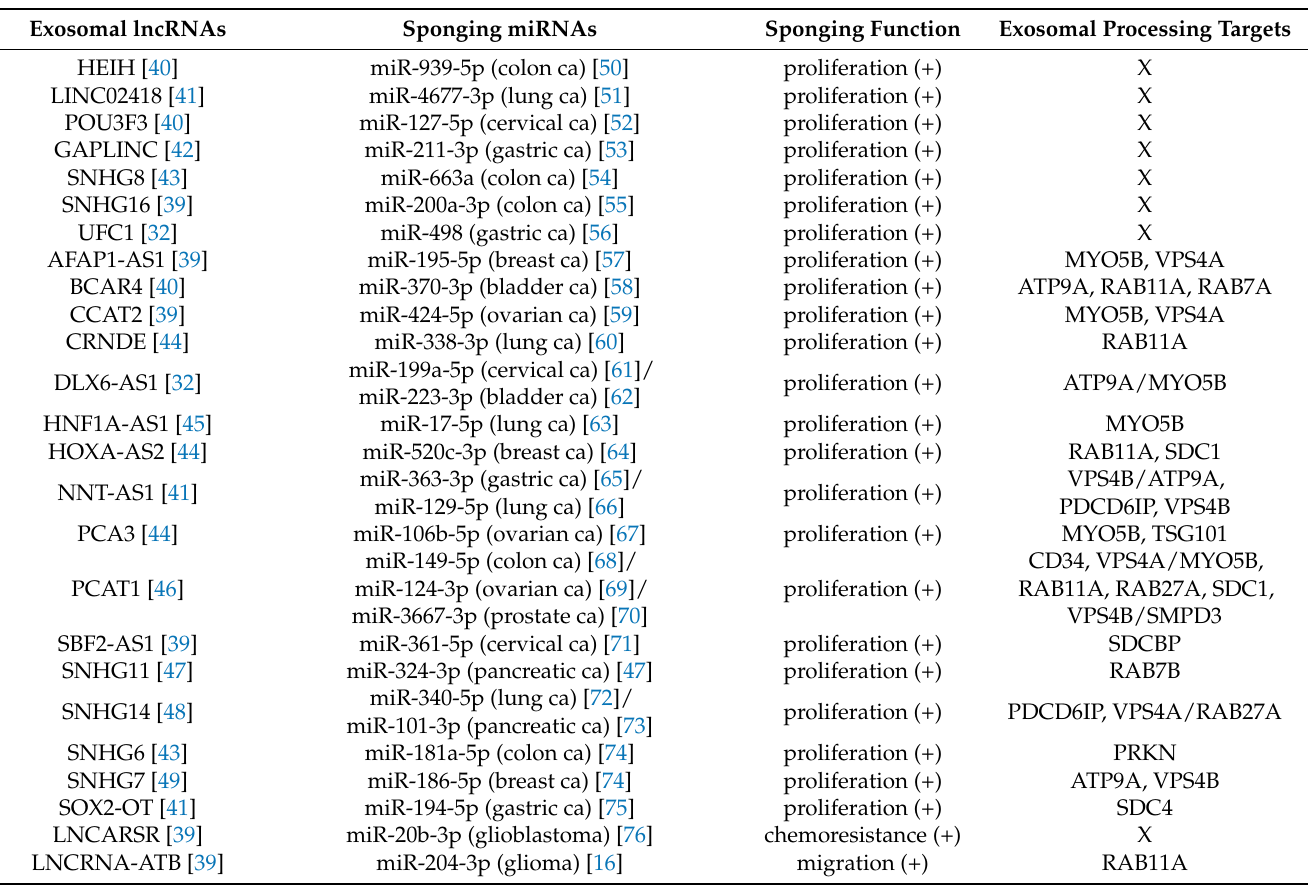
Table 1. The predicted sponging miRNAs of exosomal lncRNAs and predicted exosomal processing targets of these